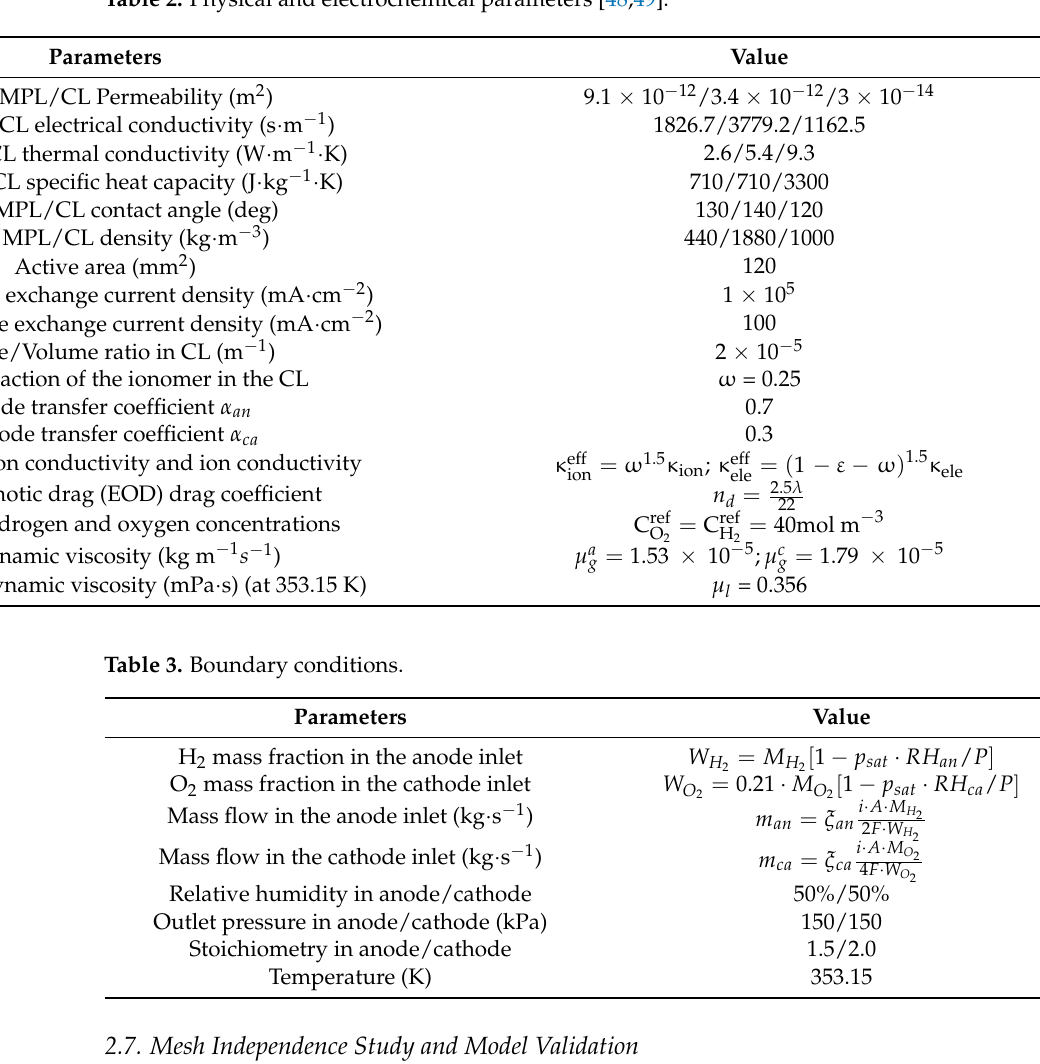
Table 2. Physical and electrochemical parameters [48,49].